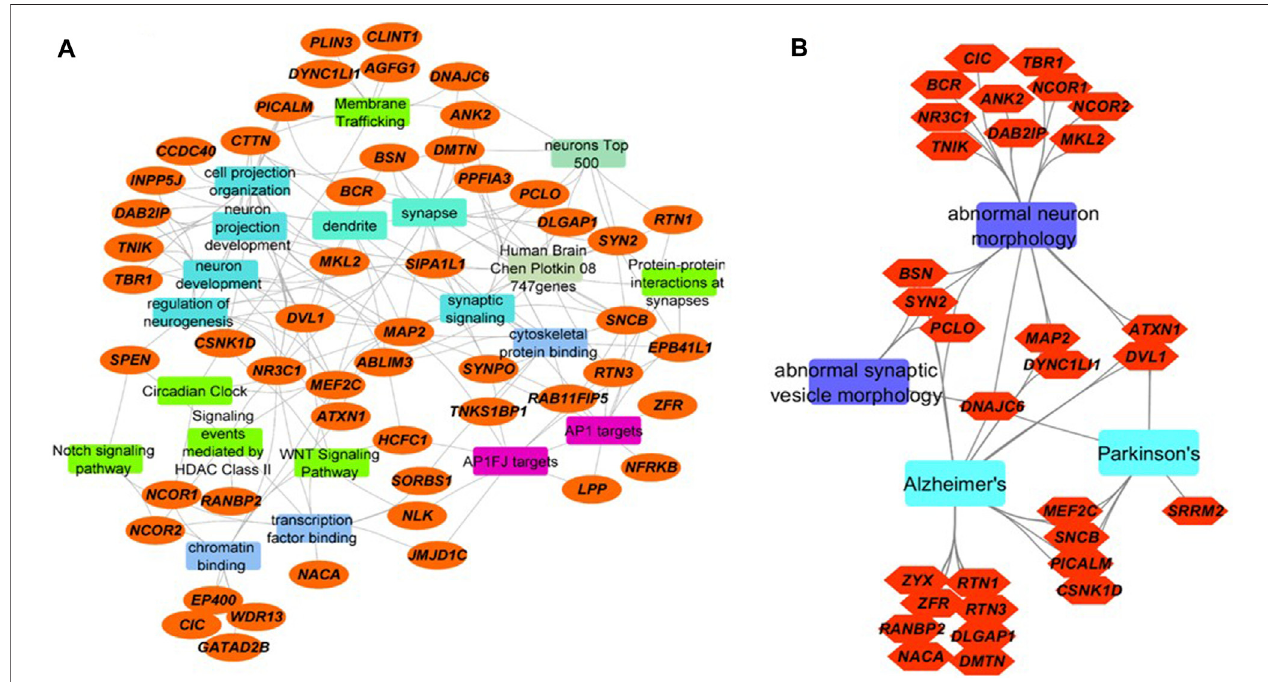
FIGURE2| Integratednetworkvisualizationsoftheinvolvementofthe65proteinswithsigni fi cantlyincreasedO-GlcNAcylationlevelsfollowingTGadministrationin cellular functions, biological processes, and phenotypes (A) We found that 52 of the 65 proteins (orange ellipses) are involved in key pathways (green rectangles), biological processes (aqua blue rectangles), cellular functions (blue rectangles), and cellular components (jungle green rectangles). Several are targets for AP-1 family of transcription factors (purple rectangles), and many of them are in Allen Brain Atlas ’ s top 500-gene list and Chen-Plotkin ’ s 747 genes that are related to human frontotemporal lobar degeneration (other colored rectangles) (B) 31 of the 65 proteins (orange hexagons) are involved in abnormal neuron morphology and abnormal synapticmorphology,aswellasneurodegenerativediseasesincludingADandPD(skyblueandvioletrectangles).Eightproteinsareinvolvedbothinabnormalneuronor synaptic vesicle morphology and AD. Three are involved both in abnormal neuron or synaptic vesicle morphology and Parkinson ’ s disease. Seven proteins are shared between AD and PD (including DNAJC6, MEF2C and